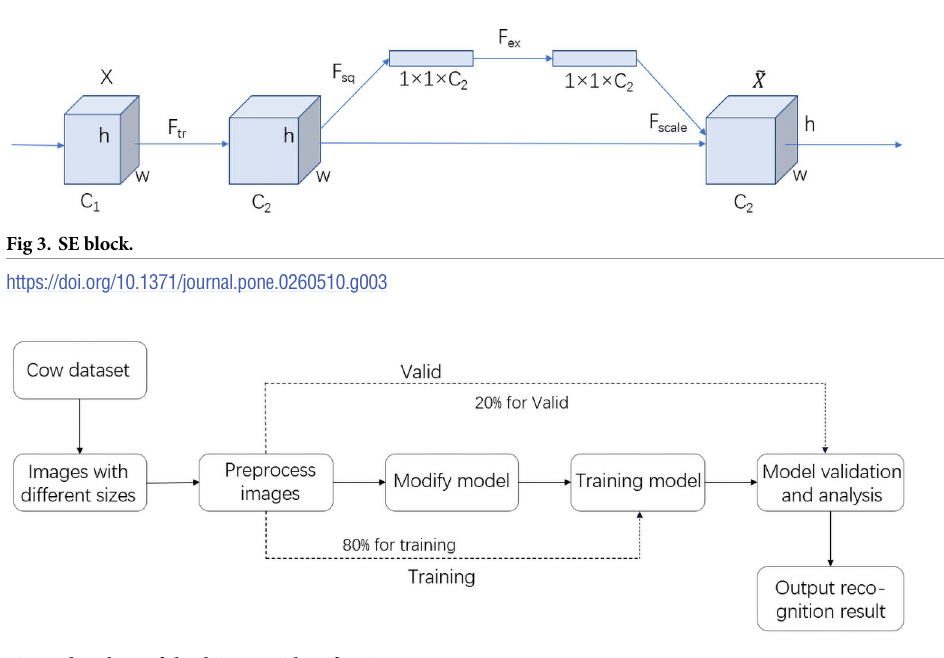
Fig 4. Flowchart of the dairy cow identification process.